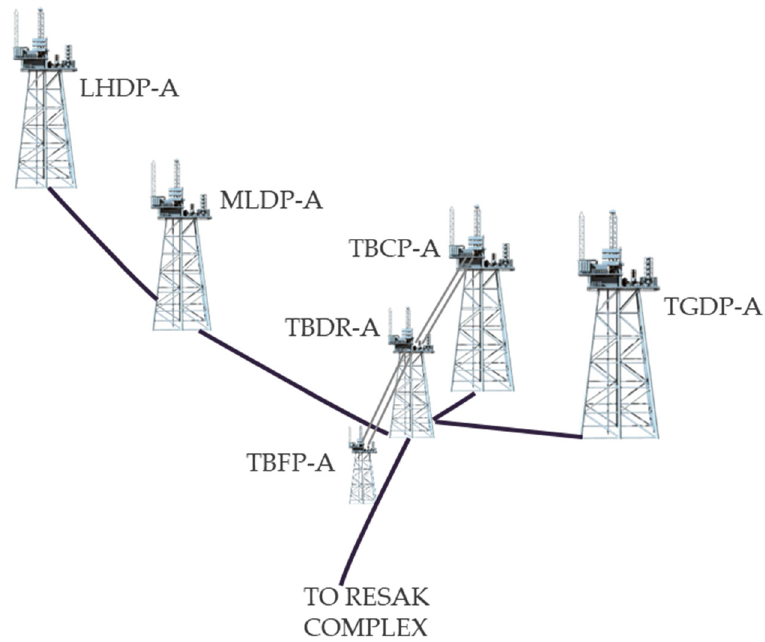
Figure 2. Tangga Barat Development Project.